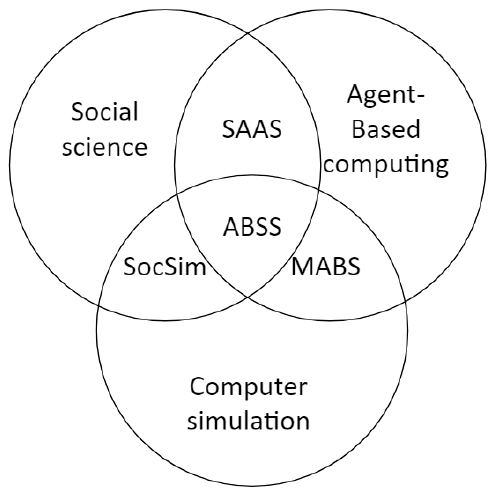
Figure 1. Intersection of different areas within the Agent-Based Social Simulation (ABSS).